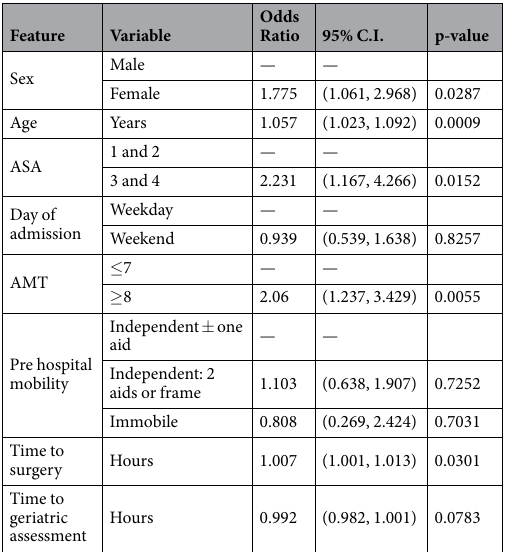
Table 2. Binomial logistic regression of 970 acute admissions comparing variables in patients who died within 30 days of admission and survived. Abbreviations: ASA = American Society of Anaesthesiologist, AMT = Abbreviated Mental